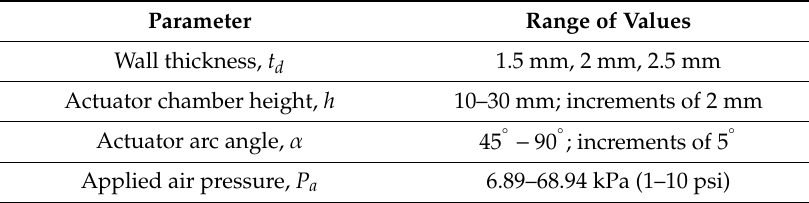
Table 1. Key design parameters and range of values for